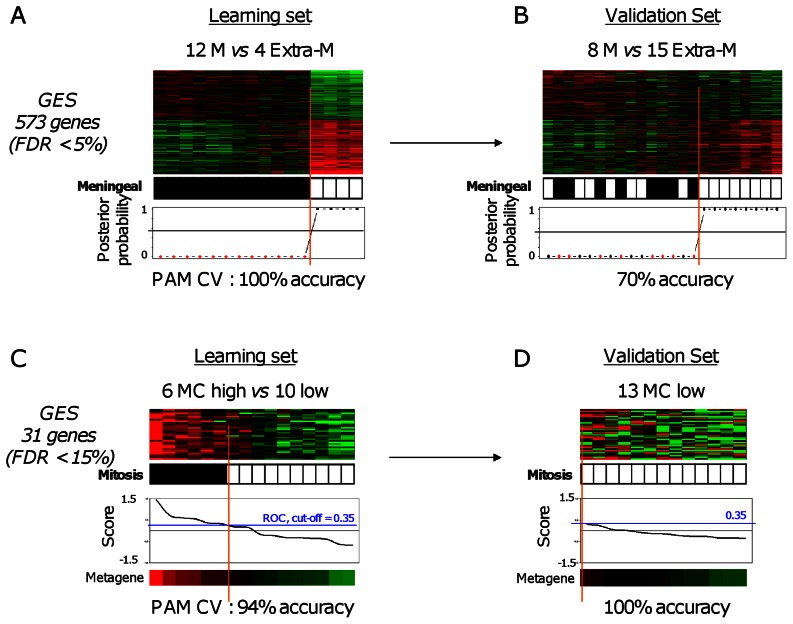
Supervised analyses of SFTs based on the location and mitotic count.
A. Legend similar to Figure 2, but applied to 16 SFT samples (12 meningeal M and 4 extra-meningeal Extra-M). The signature includes 573 genes. Samples are ordered from left to right according to the decreasing correlation coefficient of their expression profile with the mean profile of the meningeal samples. The solid vertical line indicates the threshold of 50% (equiprobability according to PAM model) that separates the two signature-predicted classes of samples. The genes are ordered form top to bottom according to their decreasing SAM statistics of meningeal SFT association. B. Similar to A, but applied to the 23 samples from the independent validation set (8 meningeal M and 15 extra-meningeal Extra-M). C. Similar to A, but applied to 16 SFT samples (10 with low mitotic count MC and 6 with high count). The signature includes 31 genes. Samples are ordered from left to right according to the decreasing metagene score. The solid vertical line indicates the optimal cut-point (0.33) defined using ROC analysis that separates the two signature-predicted classes of samples. D. Similar to C, but applied to the 13 samples from the independent validation set (all with low mitotic count).